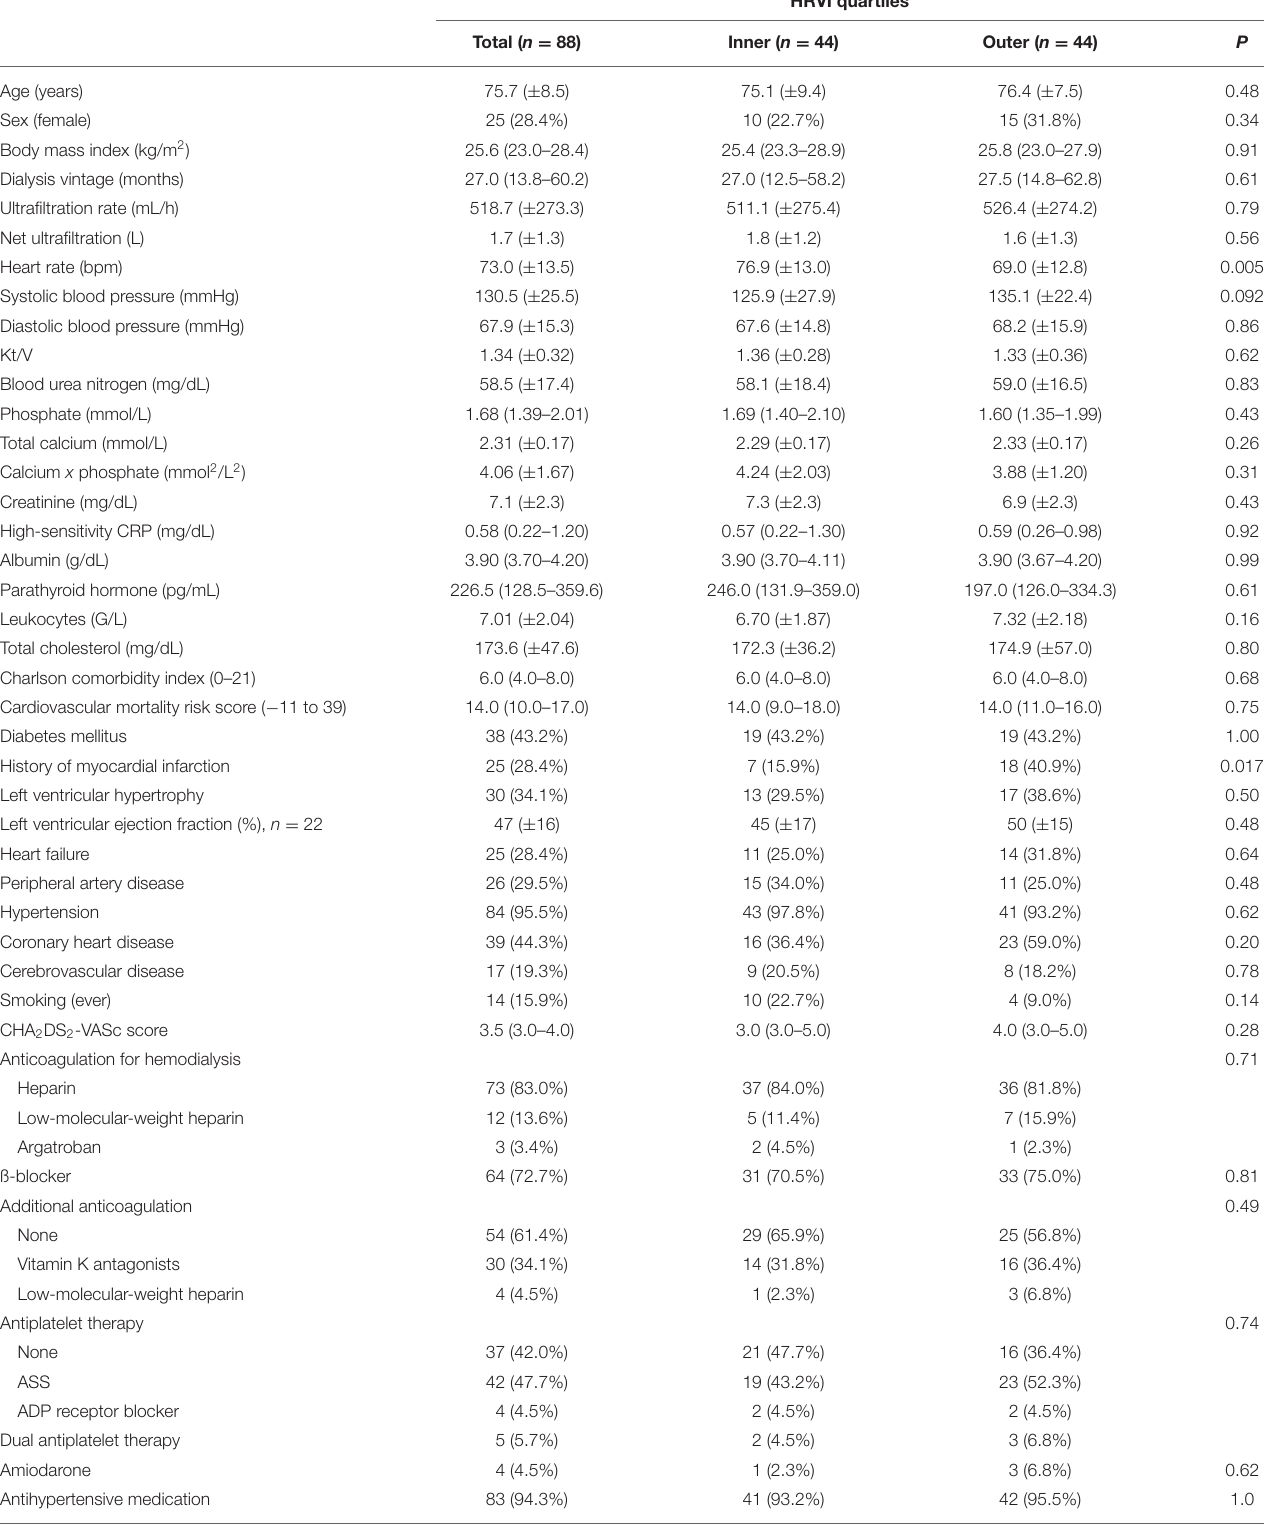
TABLE 1 | Baseline